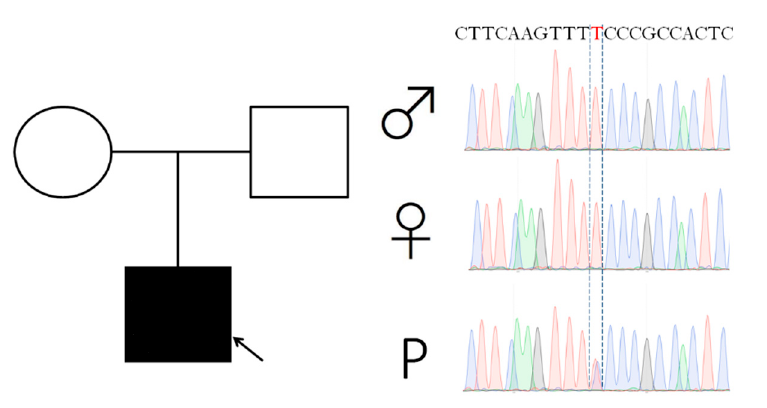
Figure 1. Pedigree and KCND3 Sanger sequencing of the index patient. Patient is pointed by an arrow. P: patient.